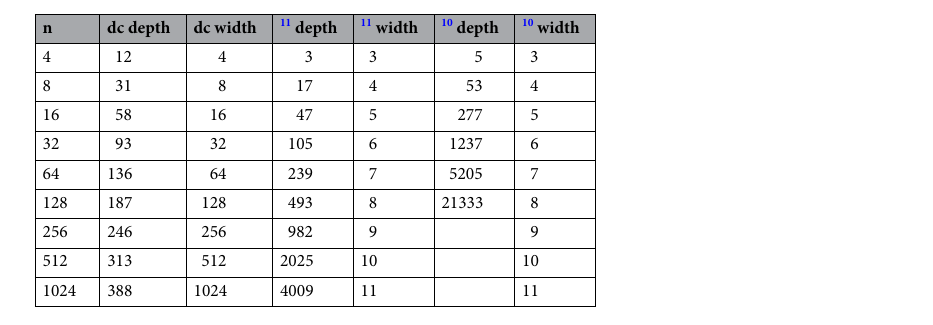
Table 1. A comparison between Refs. 10,11 and divide-and-conquer strategy to load a n -dimensional real vector into a quantum